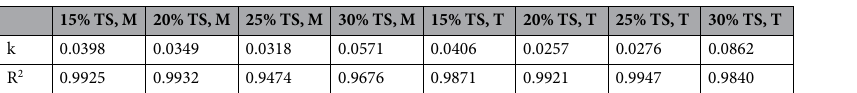
start to the reactor and utilized biodegradable waste much efficiently compared to mesophilic temperature 24 . However, TS content of 30% showed 13% ( p < 0.05) lesser consumption as compared to 25% TS of cellulose at thermophilic temperature (Table 4). This could be ascribed to the fact that increased TS content at thermophilic temperature inhibits methanogenesis and high solid concentration results in VFA accumulation and increase VFA to alkalinity ratio 9,24 .